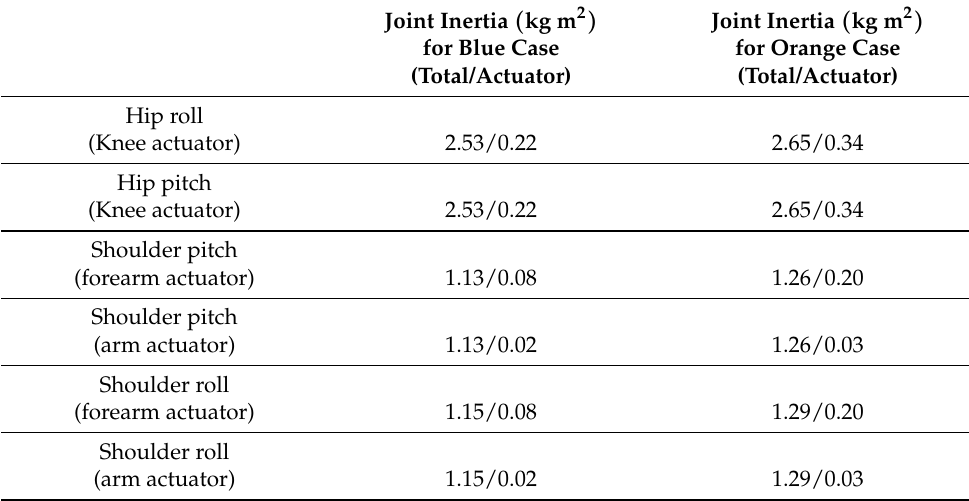
Table 3. Comparison of inertia values for various actuators and